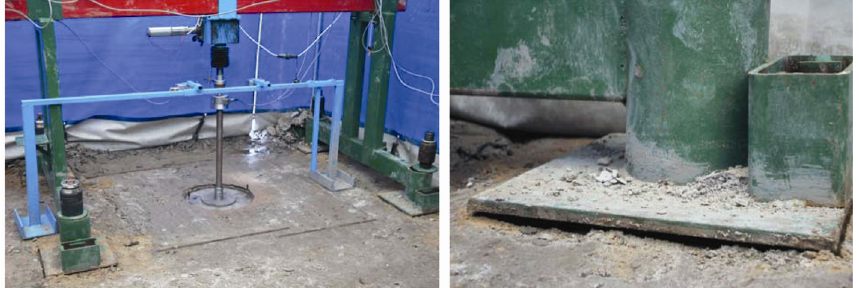
Fig. 9. Plate load test on 40 cm circular surface